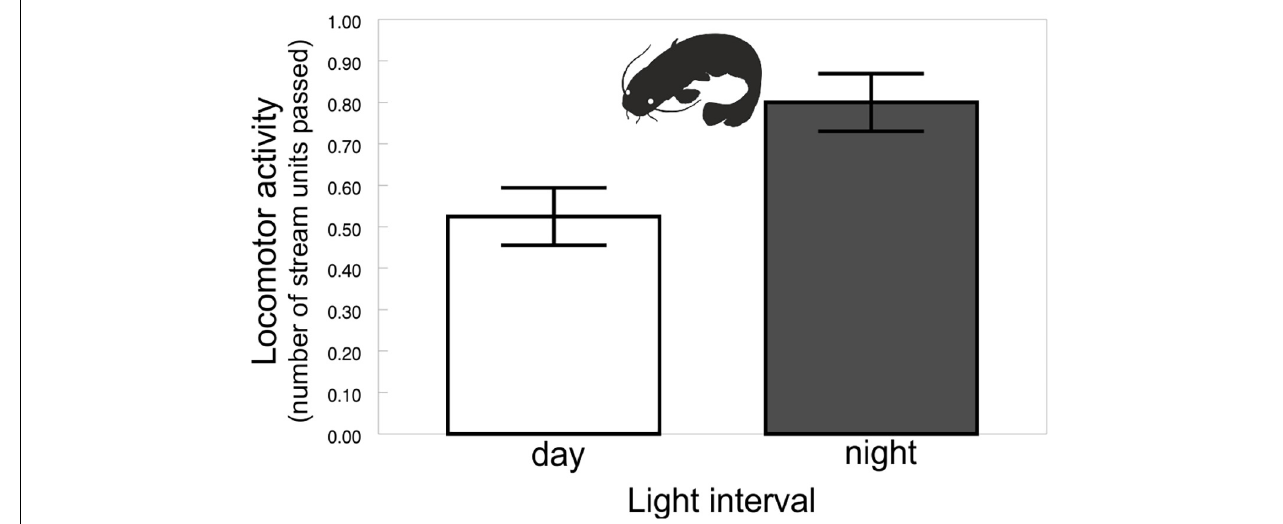
FIGURE 2 | Pigmented catfish locomotor activity in the experimental stream without shelters across light intervals. Values ( ± SEs) are predicted from the mixed model (i.e., presented data are after the adjustment by the statistical model).